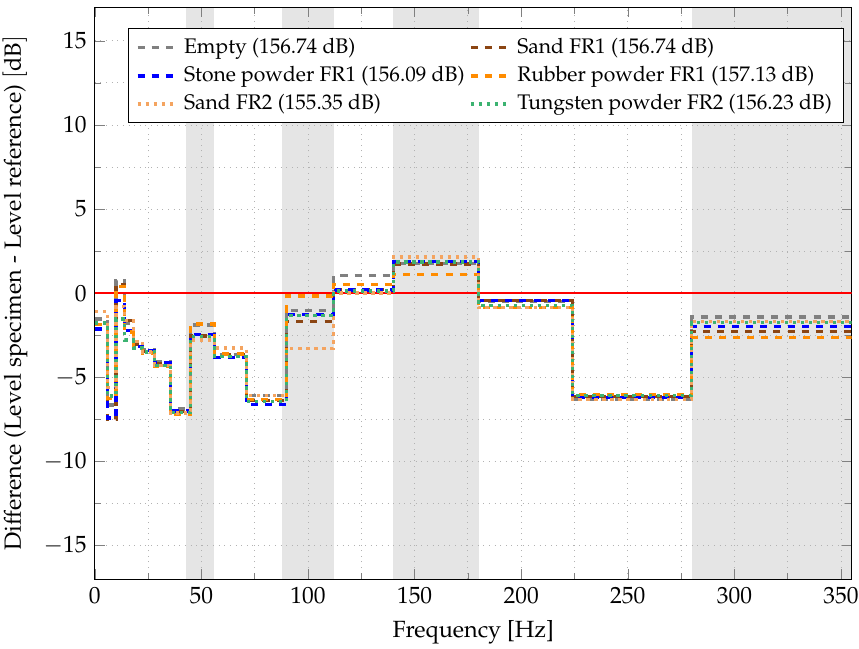
Figure A11. Difference in one-third octave band: FRF of WTS test specimen. SU HCDP mounted to the inner wall of stator ring (excitation point side). SL value of surface velocity is given in dB.